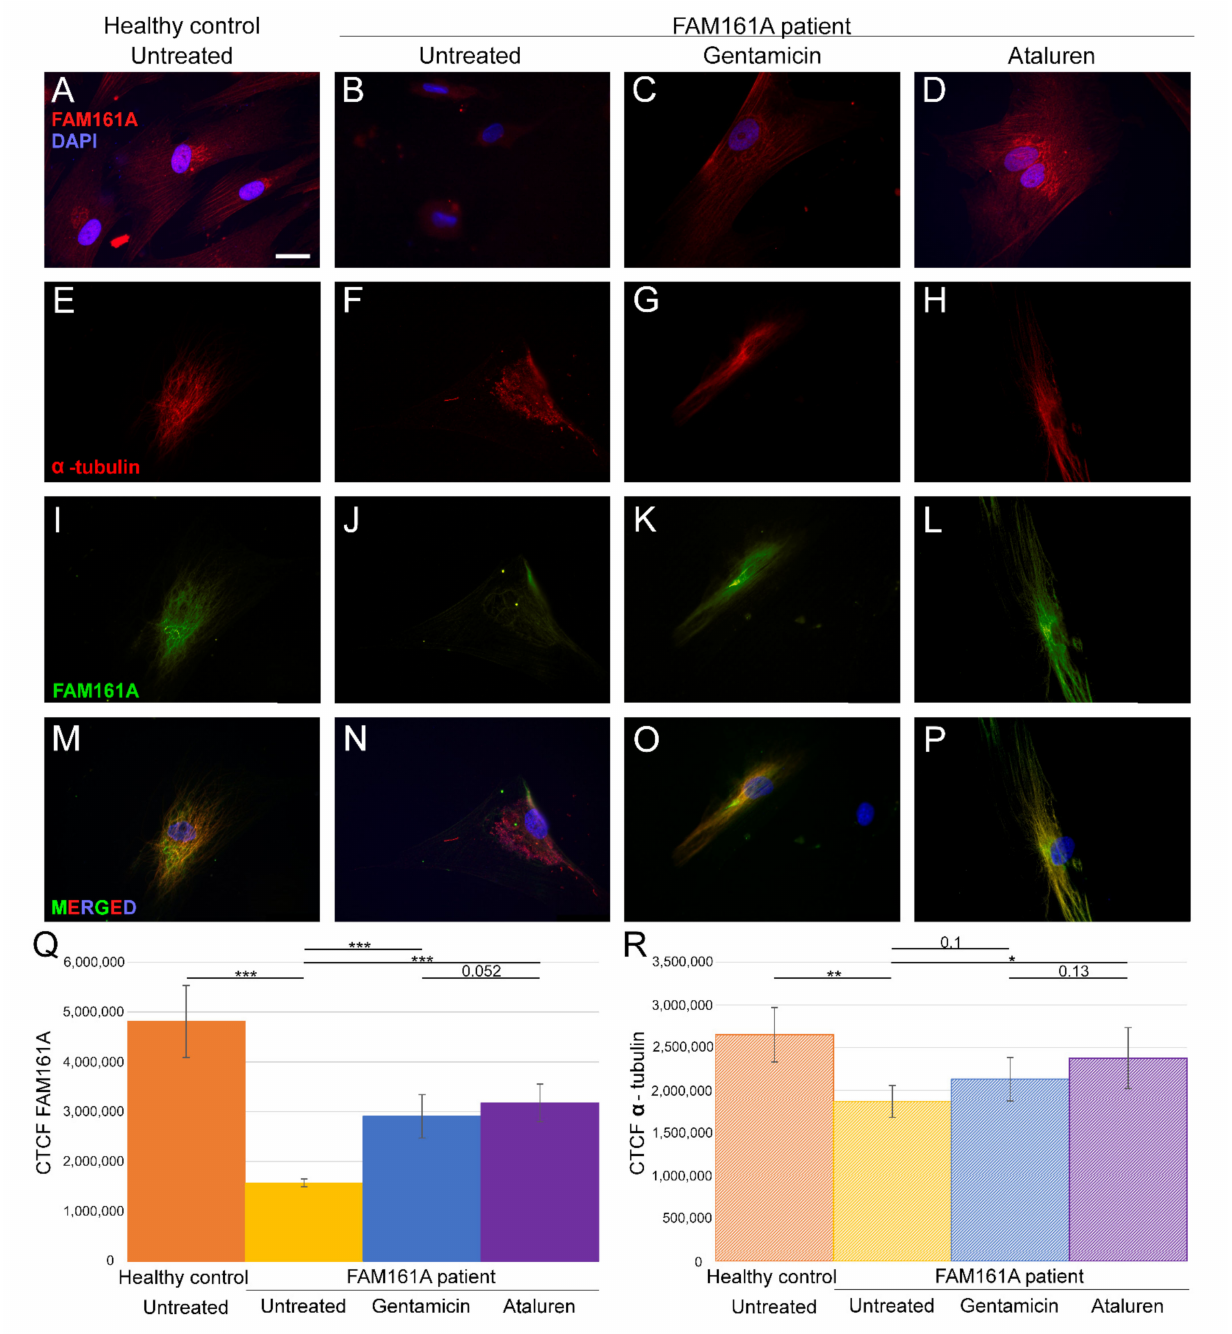
Figure 1. FAM161A expression and co-expression with α -tubulin in fibroblast cells. ( A – D ) FAM161A expression (red) after 48 h of starvation in cells from a healthy control ( A ), cells from FAM161A patient without treatment ( B ), following Gentamicin treatment ( C ) and Ataluren treatment ( D ). Double stain- ing of α -tubulin (red) and FAM161A (green) in starved fibroblasts from healthy control cells ( E , I , M ), untreated fibroblasts from FAM161A patient ( F , J , N ) and cells from the same patient treated with Gen- tamicin ( G , K , O ) and Ataluren ( H , L , P ). DAPI: nucleus (blue). Scale bar 25 µ m. ( Q , R ) Quantification of FAM161A ( Q ) and α -tubulin ( R ) expression levels in fibroblasts. Fluorescence intensities of FAM161A and α -tubulin in healthy untreated cells (orange) and untreated (yellow) Gentamicin-treated (blue) and Ataluren-treated (purple) cells from patients were measured using ImageJ, and the corrected total cell fluorescence (CTCF) was calculated (arbitrary units). The significance levels were set when p < 0.05 (*), p < 0.01 (**), p < 0.001